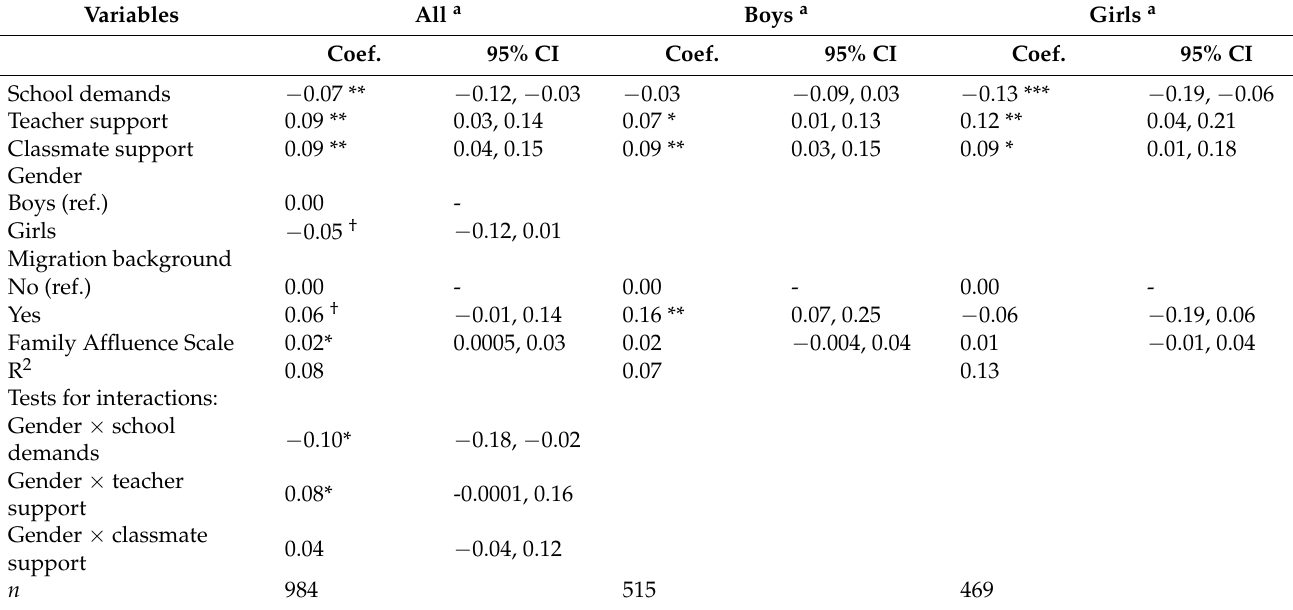
Table 1. Results from the linear probability models of excellent self-rated health among grade five students ( n = 984, distributed over 65 classes).